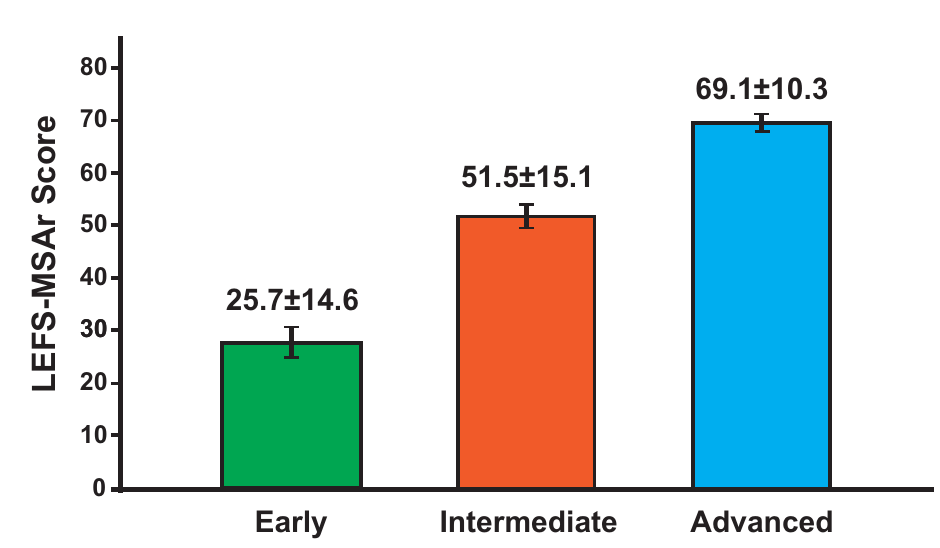
Fig 3. LEFS-MSAr scores according to the ACL rehabilitation stage. LEFS-MSAr mean( ± SD) for each of the ACL in terms of rehabilitation stage groups. Mean total score and standard error values are depicted in the graph. Significant differences were found between scores for early (median = 25.0) and intermediate (median = 53.0) group (U = 264.500, p < 0.001), early and advanced (median = 72.0) group (U = 24.000, p < 0.001), and intermediate and advanced group (U = 456.000, p < 0.001). Abbreviations: LEFS-MSAr, lower extremity functional scale modern standard Arabic version; N, sample size; ACL, anterior cruciate ligament injury patients.